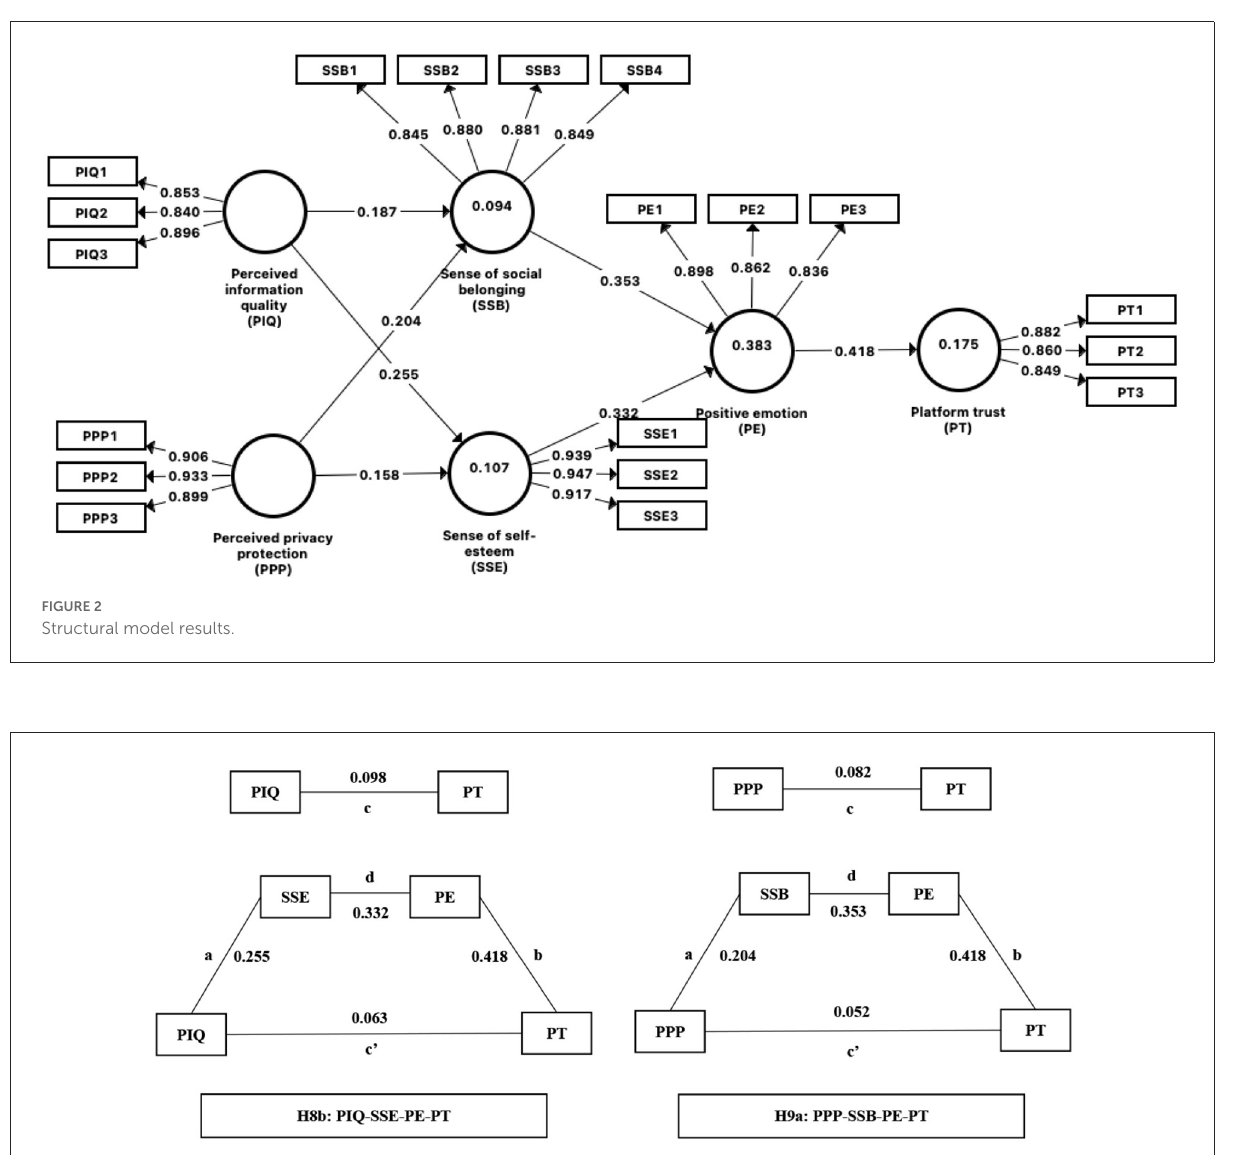
FIGURE3 Mediation model